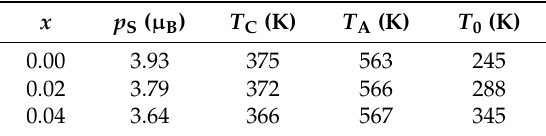
Table 1. The spontaneous magnetic moment p S and the characteristic temperatures T C , T A , and T 0 for Ni 2+ x MnGa 1 − x